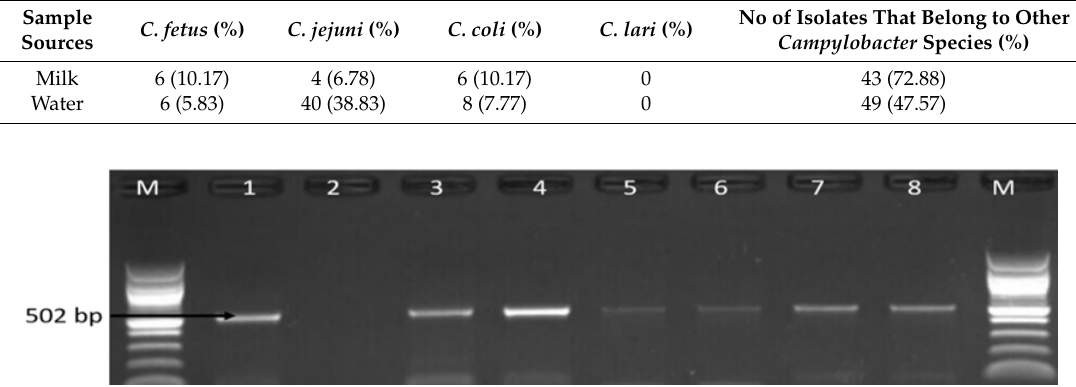
Figure 3. Gel image of PCR detected aspK (502 bp) gene of C . coli . Lane M: DNA ladder (100 bp), lane 1: positive control ( C. coli ATCC 33559), lane 2: negative control, lane 3–8: some positive C . coli isolates (502 bp).